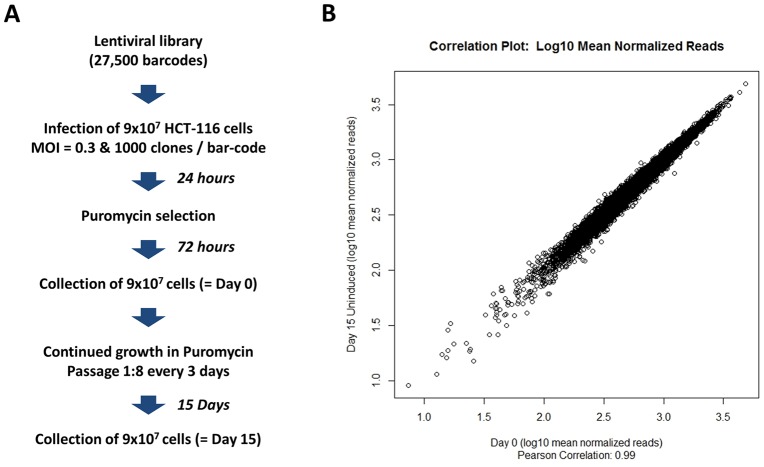
Evidence that encoded shRNA are not induced in the absence of Doxycycline in vitro.
(A) A lentiviral library containing 27,500 unique barcodes was used to transduce HCT-116 cells at a MOI of 0.3. After 72 hours, of puromycin selection, cells were continuously passaged for 15 days in the absence of Doxycycline. Day 0 and Day 15 cell aliquots were obtained and total DNA from both time points were subjected to the barcode high-throughput sequencing retrieval procedure. (B) Correlation plot for Day 15 measurement against Day 0. shRNA barcode reads for all samples from all time points were first normalized to 2×107 reads. Values for triplicate samples were averaged. At Day 15, strong repression of shRNA expression in the absence of Doxycycline is evident in the correlations with the Day 0 reference. Plot of log10 mean normalized reads for Day 0 against Day 15 (Pearson correlation: R = 0.99).